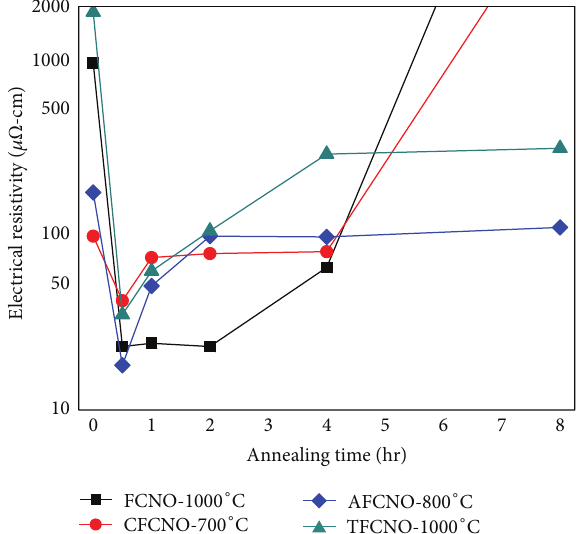
Figure 6: Plot of the resistivity of the thin films versus annealing times. The annealing temperatures for the FCNO, TFCNO, CFCNO, and AFCNO thin film were 1000 ∘ C, 1000 ∘ C, 700 ∘ C, and 800 ∘ C,